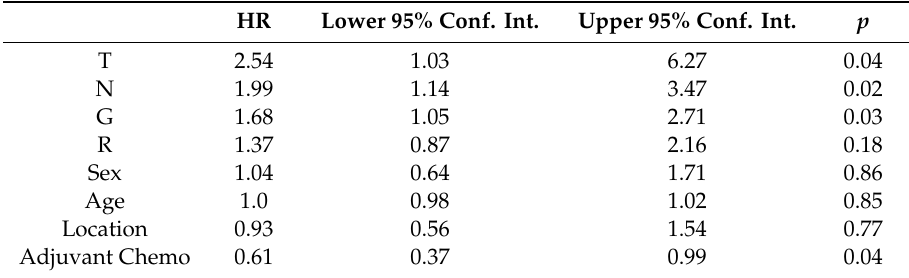
Table 2. Results of the Cox proportional hazards modelling for parameter group 1 (clinical parameters). HR Lower 95% Conf. Int. Upper 95% Conf. Int.